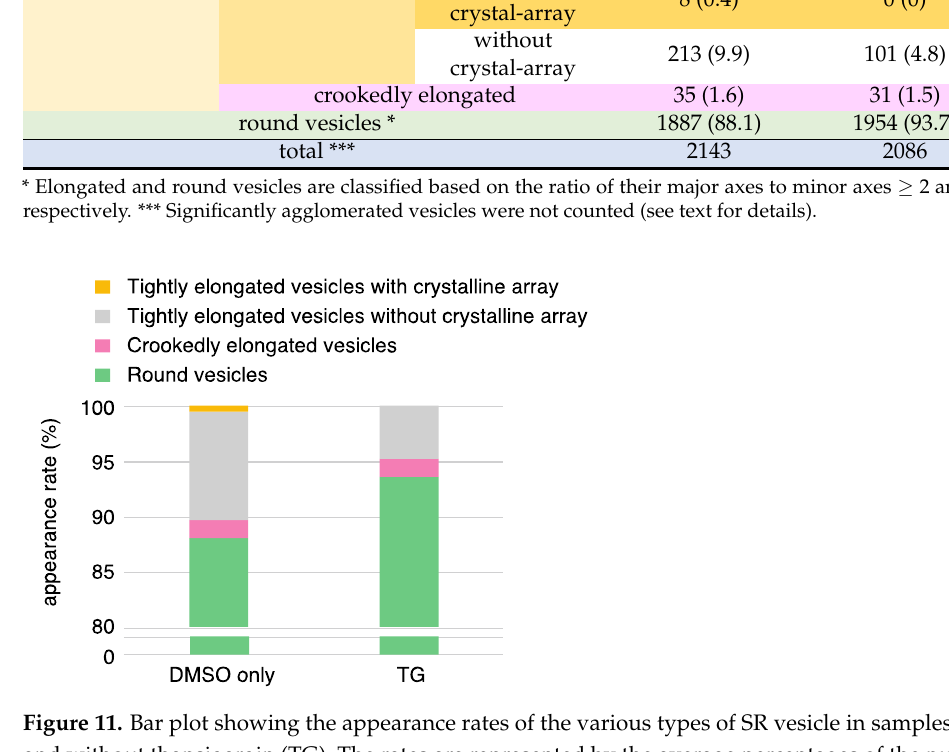
351 352 353 354